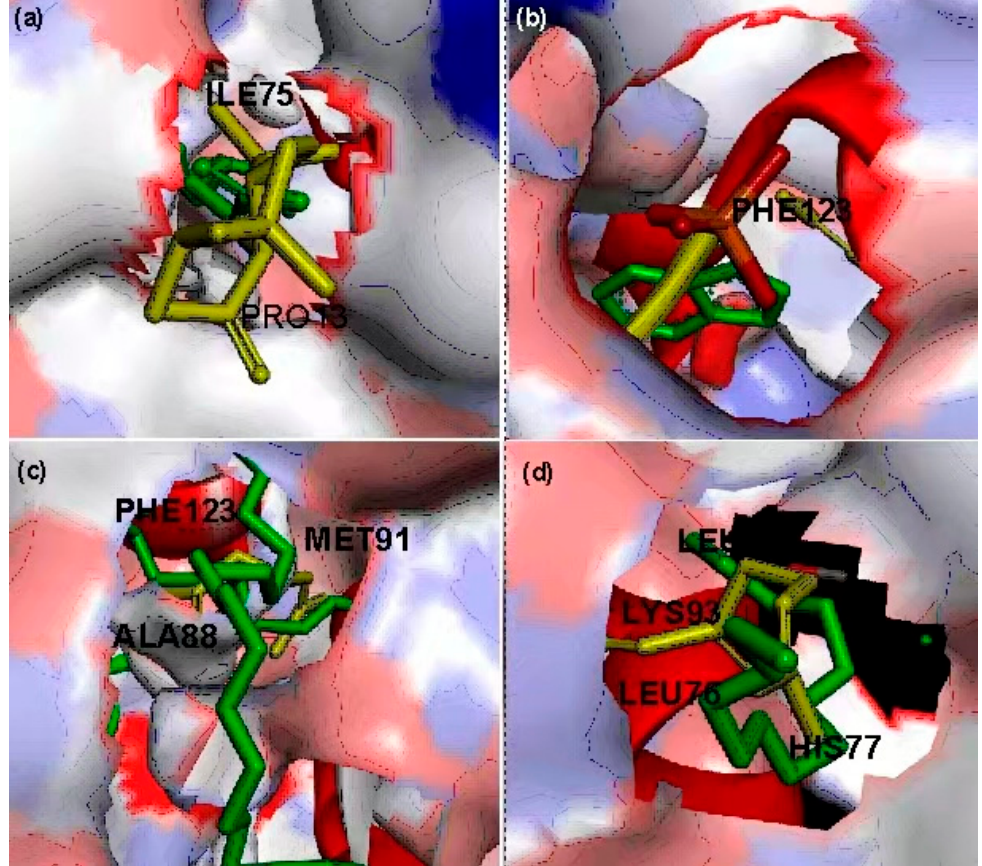
Figure 10. 3D images of the active pockets of ( a ) OBP 7, ( b ) OBP 1, ( c ) OBP, and ( d ) OBP 4 showing the native ligand (green) and the experimental ligand (yellow).